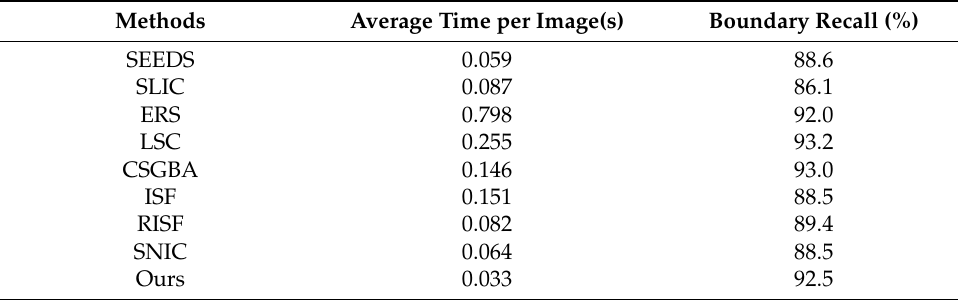
Table 2. The comparison of the efficiency and BR ( M ≈